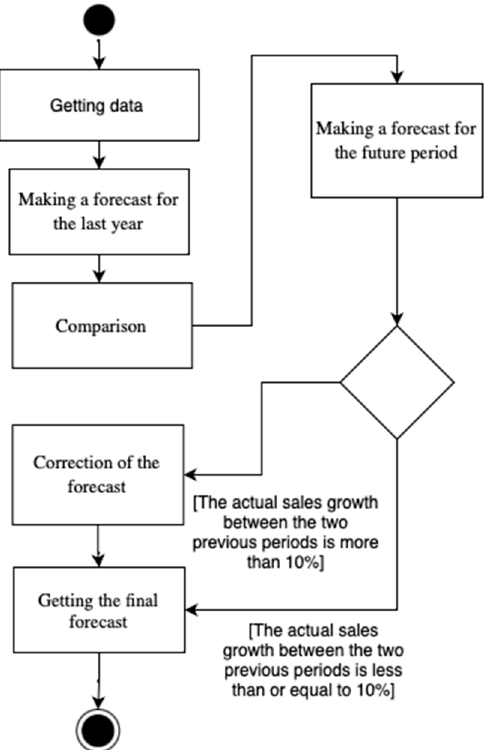
Figure 2. Algorithm of forecasting by the “past sales turnover” method. The final forecast, adjusted for accuracy, was 55,531 units. The actual order volume for 2021 was 55,028 units. The accuracy of the forecast adjusted for accuracy of the previous year was 99.1%.